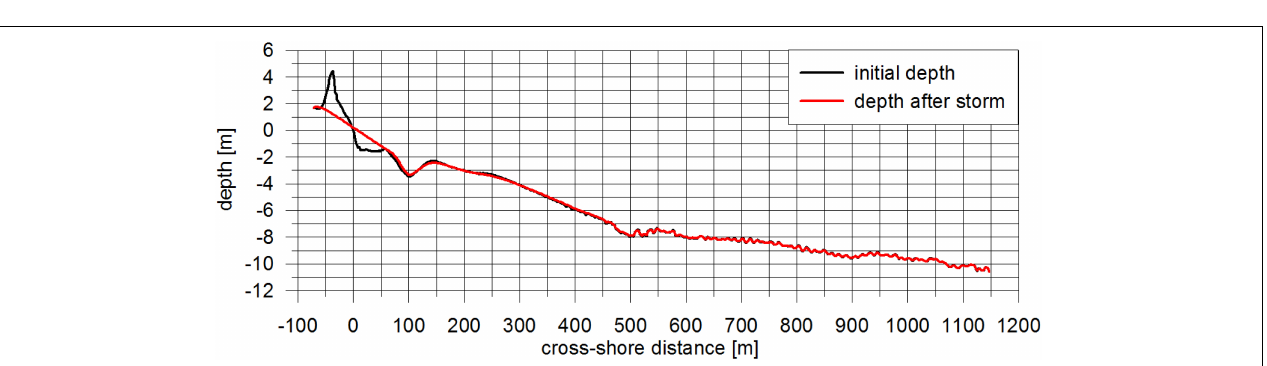
FIGURE 9 | Results of simulation of storm effect for Jamno barrier, km 295, total surge 1.3 m.